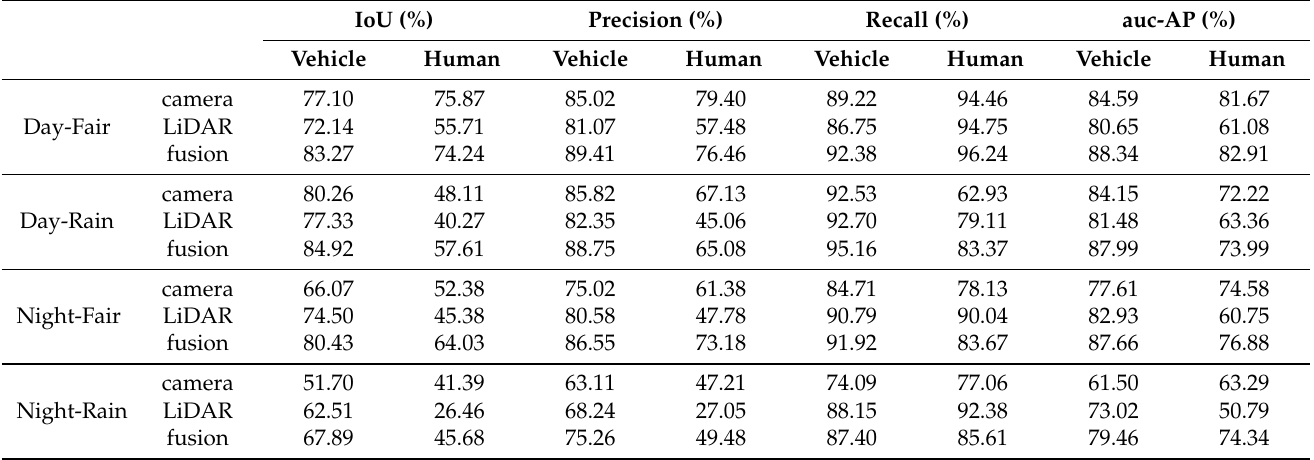
Table 4. Performance of the iseAuto transfer learning models from the Waymo dataset.